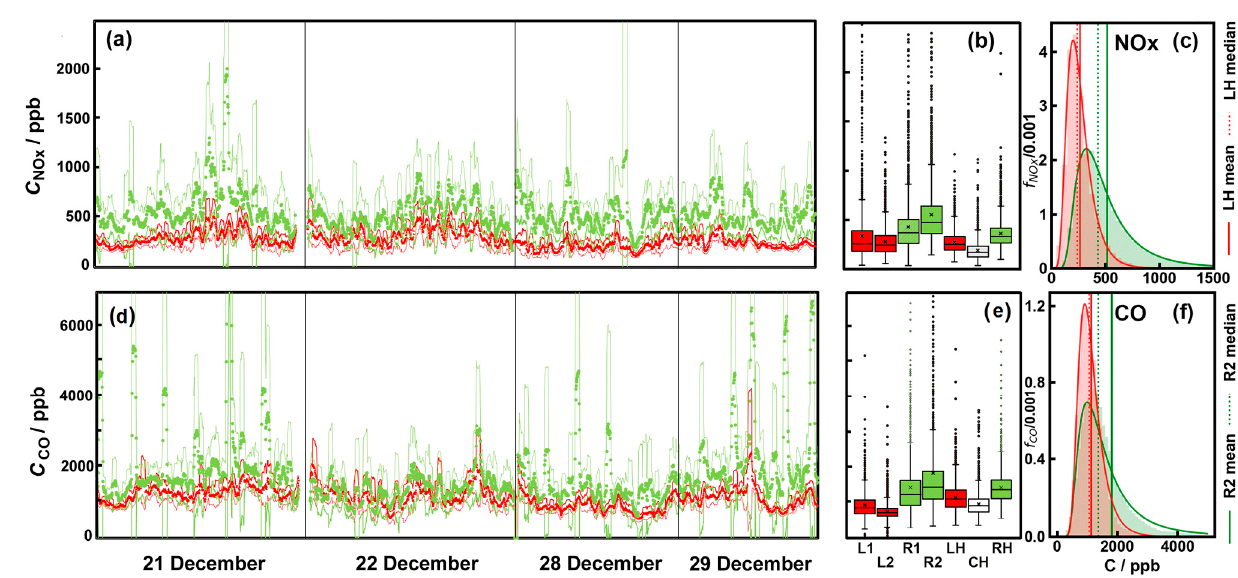
Figure 3. ( a ) One-minute concentrations of NOx smoothed over 15 min for the four campaigns near the traffic (node R2: green dots) and from the covered kerb (node LH: red triangles appear as a thick line). Thin lines are the boundaries of the standard deviations. ( b ) Box and whisker plots of 1-min average concentrations at the seven nodes. Note: the boxes define quartiles Q 1 and Q 3 , the median is denoted with a line and the mean by “x”. ( c ) The 1-s NOx concentrations from nodes LH and R2 fitted to a Weibull distribution. ( d ) One-minute concentrations of CO smoothed over 15 min for node R2 (green dots) and LH (red triangles appear as a thick line) over the four days. Thin lines are the boundaries of the standard deviations. ( e ) Box and whisker plots of 1-min average concentrations of CO at the seven nodes. ( f ) The 1-s CO concentrations from nodes LH and R2 fitted to a Weibull distribution.